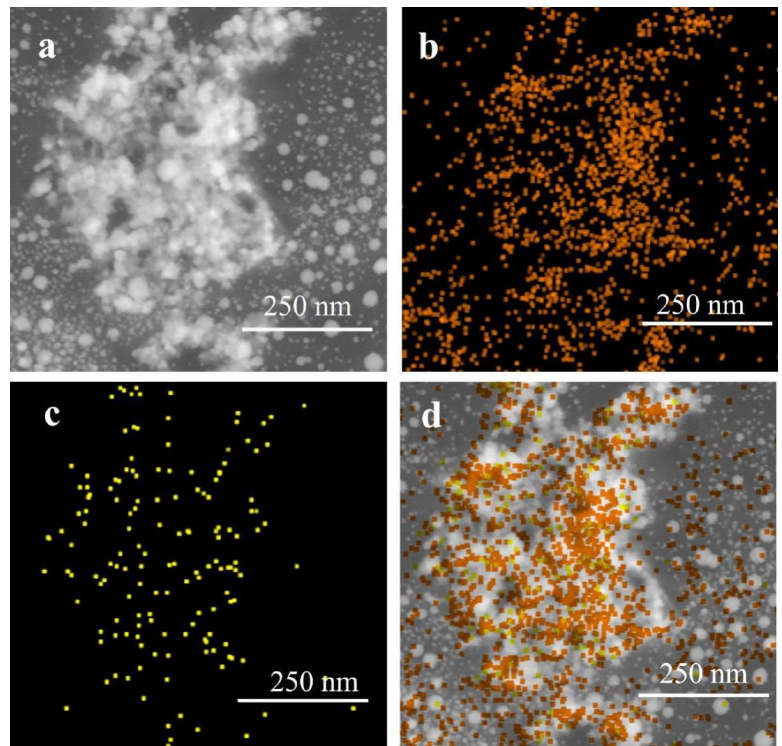
Figure 7. ( a ) Selective area TEM image of CMS/PVP-Ag NPs in the presence of Hg 2+ , ( b ) elemental mapping images of Hg, ( c ) Ag and ( d ) elements superimposed images. 3.3. Mechanism Study for the CMS/PVP-Ag NPs Colloidal Solution and the Detection of Hg 2+ and Fe 3+ Figure 8 exhibits the reaction scheme and mechanism of the CMS/PVP-Ag NPs col- loid for the detection of Hg 2+ and Fe 3+ . The synthesis processes involve adsorption, in situ reduction and a complexation/oxidation process. As previously mentioned, CMS and PVP were self-assembled to form the stabilized skeleton and the silver ions were uniformly anchored on the surface of the CMS molecules via a non-covalent bond. Subsequently, the glucose molecules containing aldehyde groups act as the reducing agent to form the Ag NPs through a silver mirror reaction . The larger steric hindrance effect caused the Ag NPs to be uniformly dispersed and not easy to coalesce, as shown in Figure 8b. It was observed that when Hg 2+ was added into the CMS/PVP-Ag NPs colloidal solution, it became color- less and the SPR band intensity diminished with a blue shift (see Figure 4a), which can also be demonstrated by the morphology changes shown in Figure 8a. The size of Ag NPs was changed from about 25 nm to 50 – 150 nm in Figure 8b and induced the aggregation of Ag NPs. Furthermore, the detective absorption of Hg 2+ was examined by a redox reaction with Ag 0 and Hg 2+ . The generated Hg 0 adhered to the surface of Ag NPs, forming the Ag – Hg amalgam to enlarge the aggregation of Ag NPs (Figure 8b) [45]. When Fe 3+ was added to the CMS/PVP-Ag NPs colloidal solution, it became colorless and the SPR band intensity diminished without any red or blue shift in Figure 5a. It indicated that the concentration of Ag NPs in the solution decreases, but the size of Ag NPs remained unchanged, which